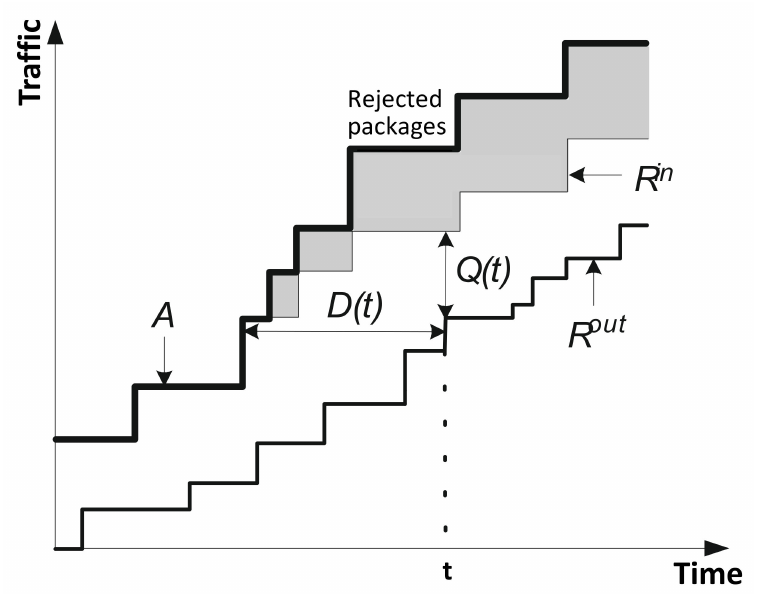
Figure 3. Queue size, delay and packet